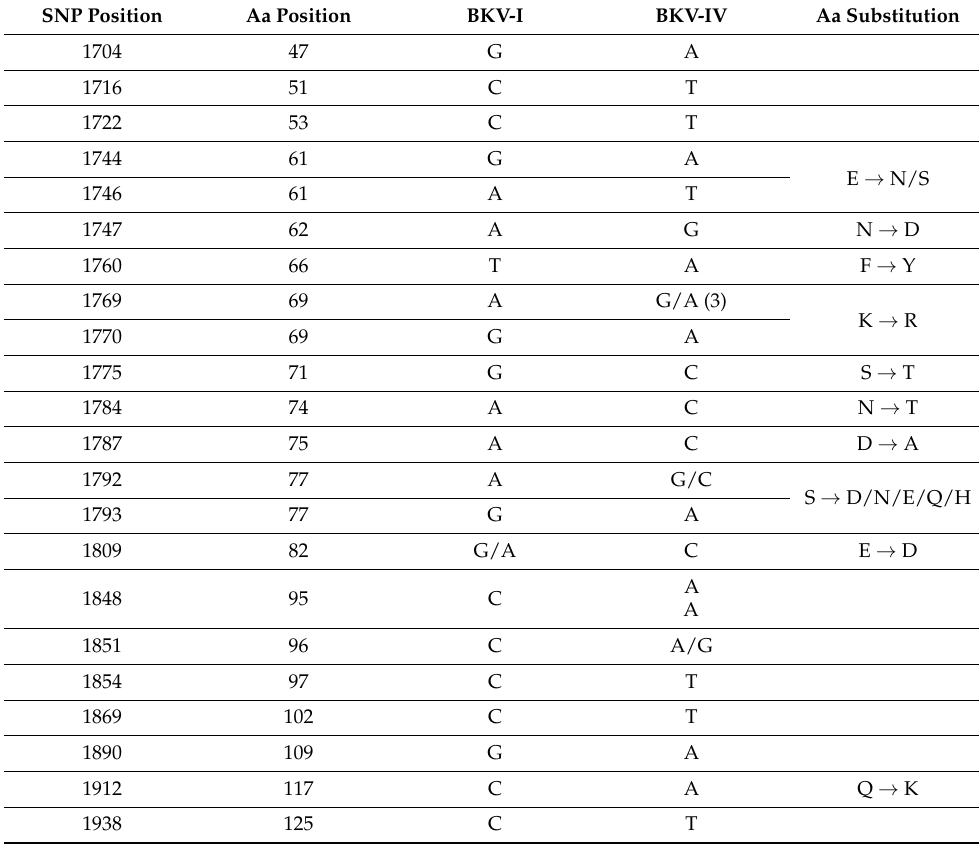
Table 7. SNP difference between BKV-I and BKV-IV.